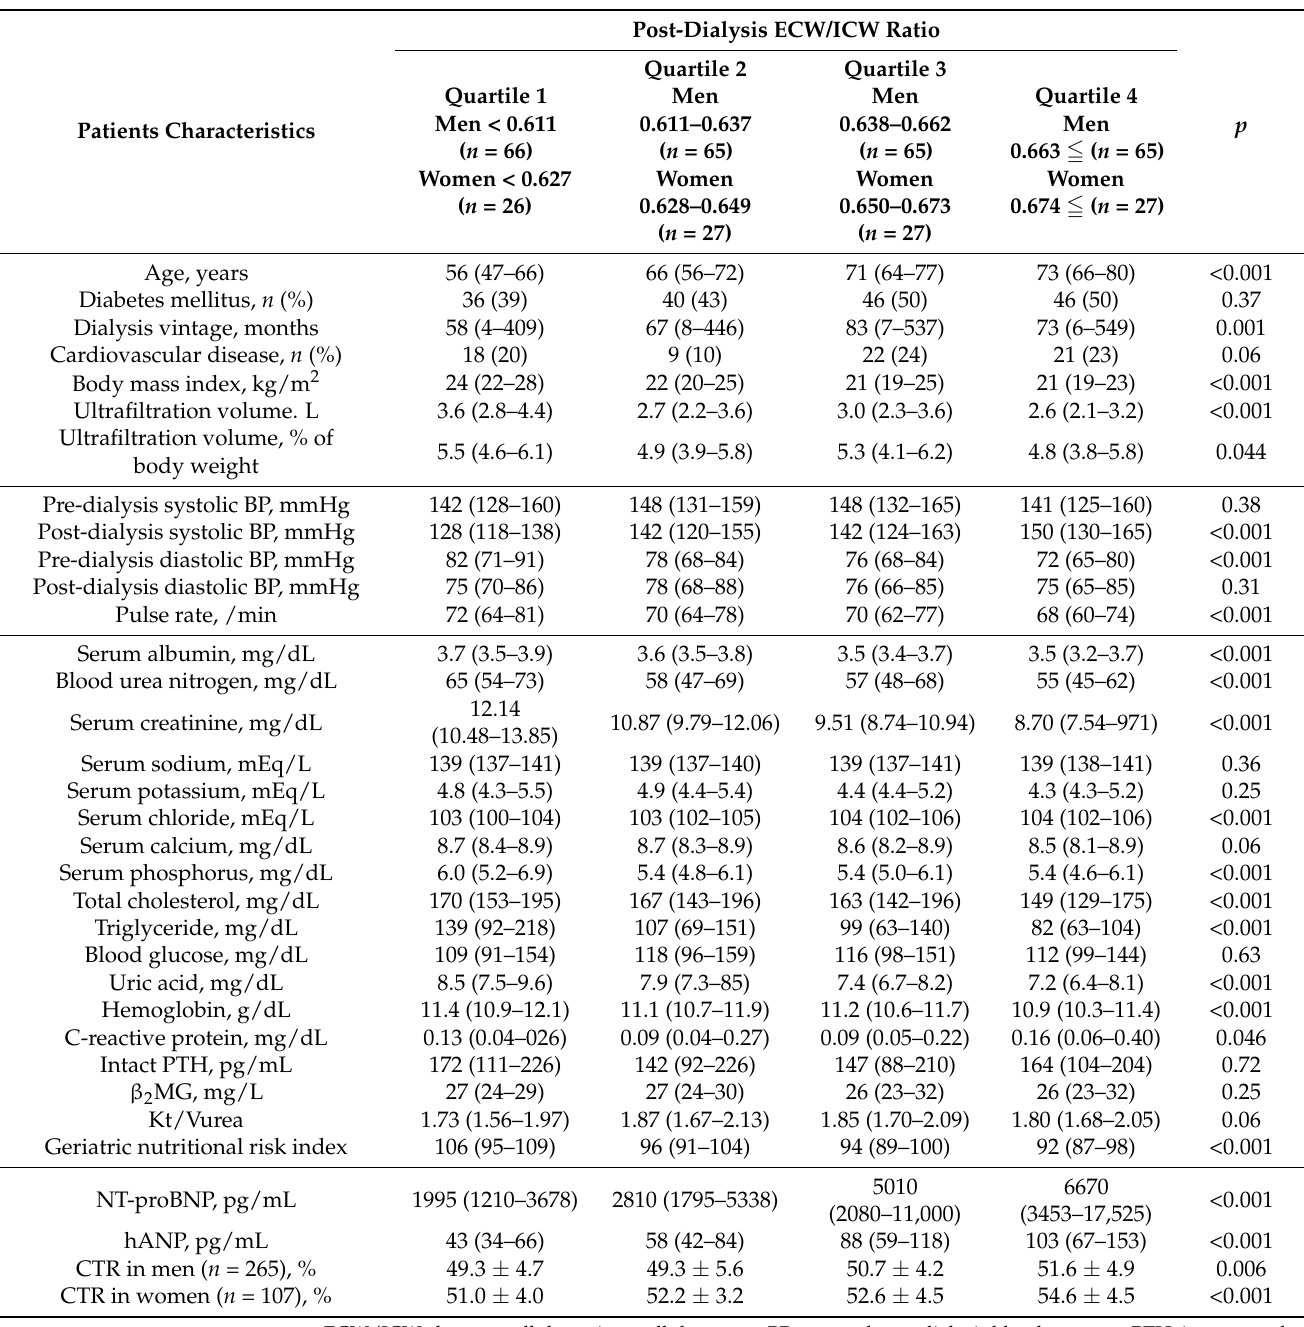
Table 1. Population characteristics according to the post-hemodialysis ECW/ICW ratio quartiles.